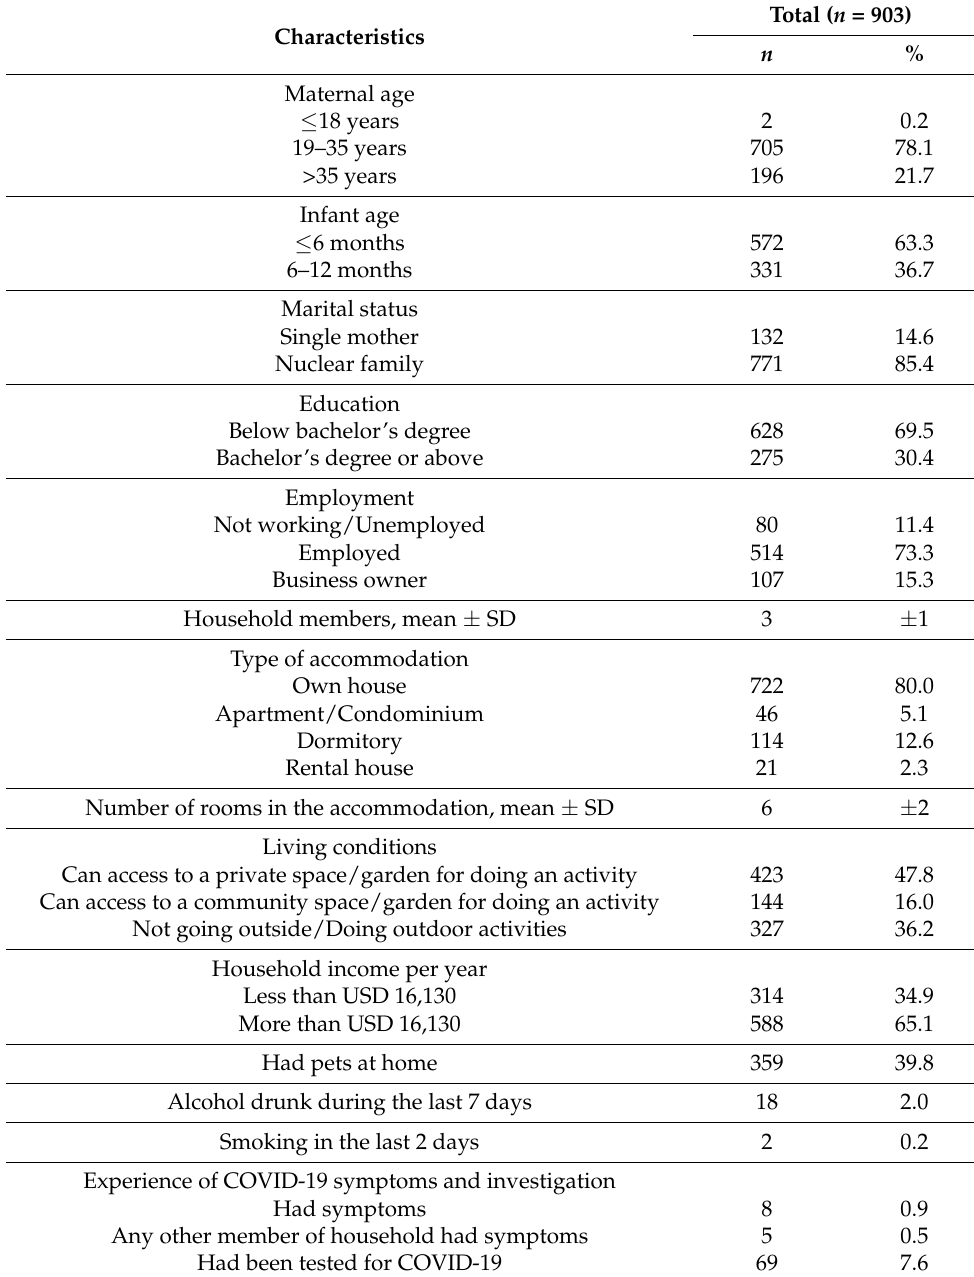
Table 1. The characteristics of participants and